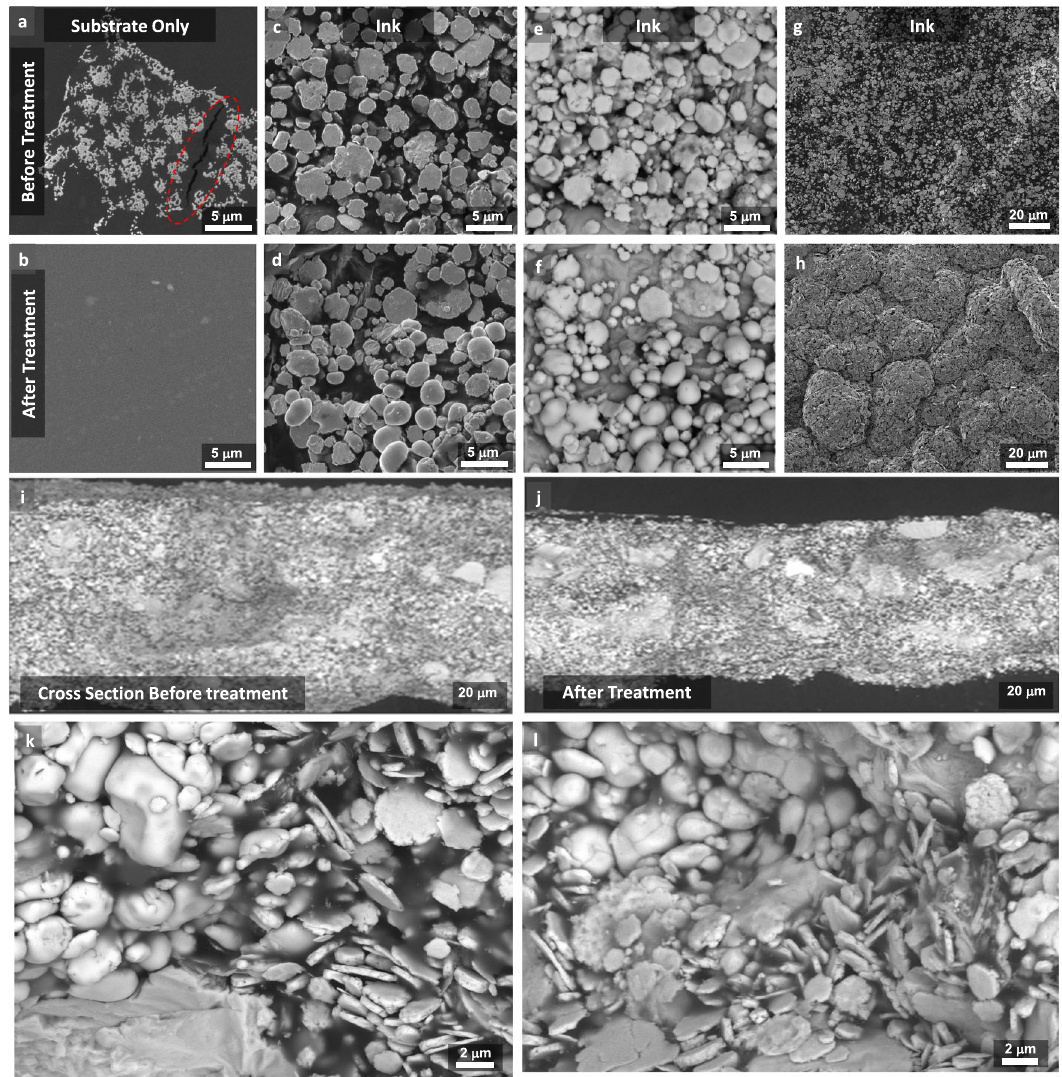
Fig. 3 Scanning electron microscopy. SEM of the substrate and the printed ink before and after vapor exposure. SIS substrate before ( a ) and after ( b ) the exposure. The SE images of the ink before ( c ) and after exposure ( d ). The BSE images of the ink before ( e ) and after exposure ( f ). Highly diluted ink spray coated over the textile before ( g ) and after ( h ) vapor exposure. Cross section of SEM images of the printed ink before ( i , k ) and after vapor exposure ( j , l